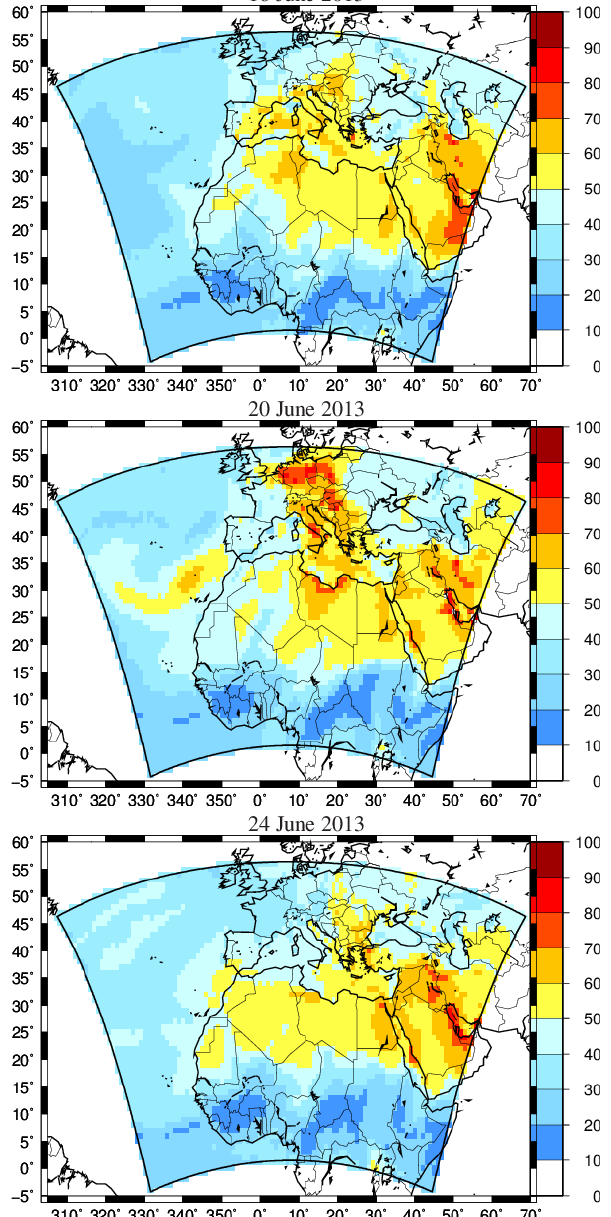
Figure 9. Modeled surface ozone concentrations (µgm − 3 ) for 16, 20 and 24 June 2013 at 12:00UTC.